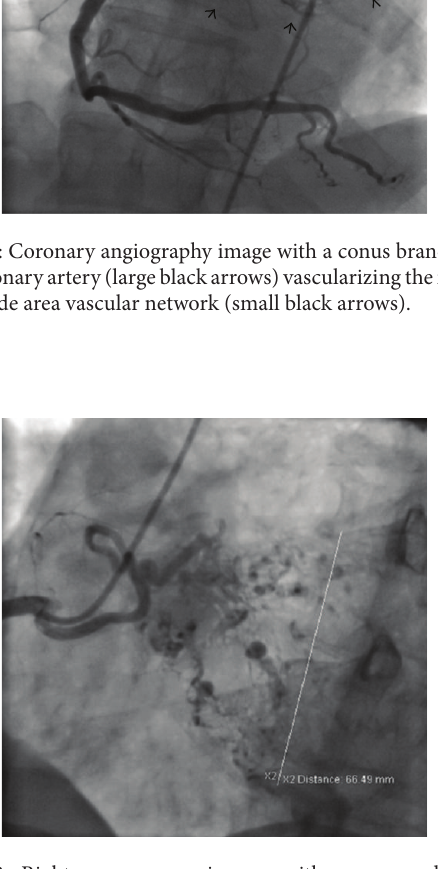
Figure 3: Right coronary angiogram with zoom mode shows diameter of left atrial myxoma vascularity by conus